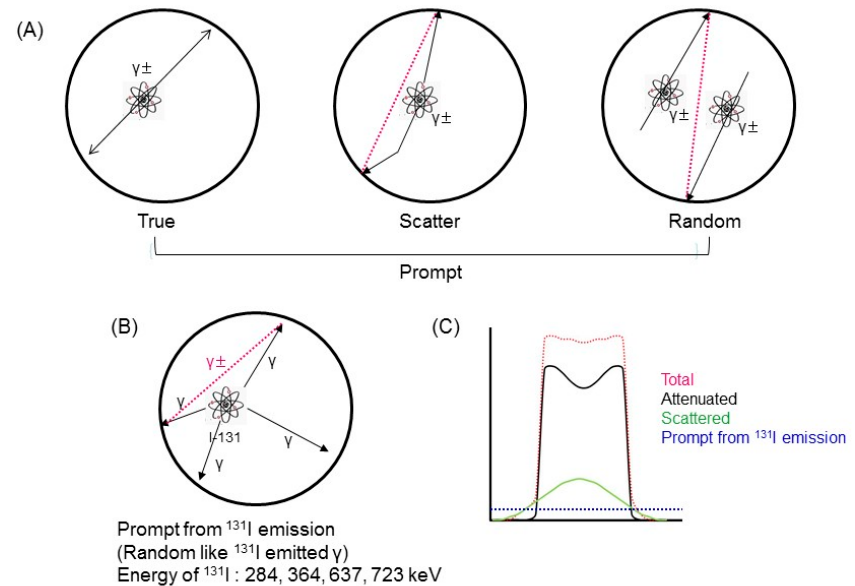
Figure 1. Schematic illustration of emissions. ( A ) Schematic of Positron Emission Tomography (PET) emissions, such as true, scatter, and random emissions during annihilation. ( B ) 131 I prompt emission. 131 I emitted 284, 364, 637, and 723 keV gamma rays. ( C ) Schematic of 131 I prompt emission profile.